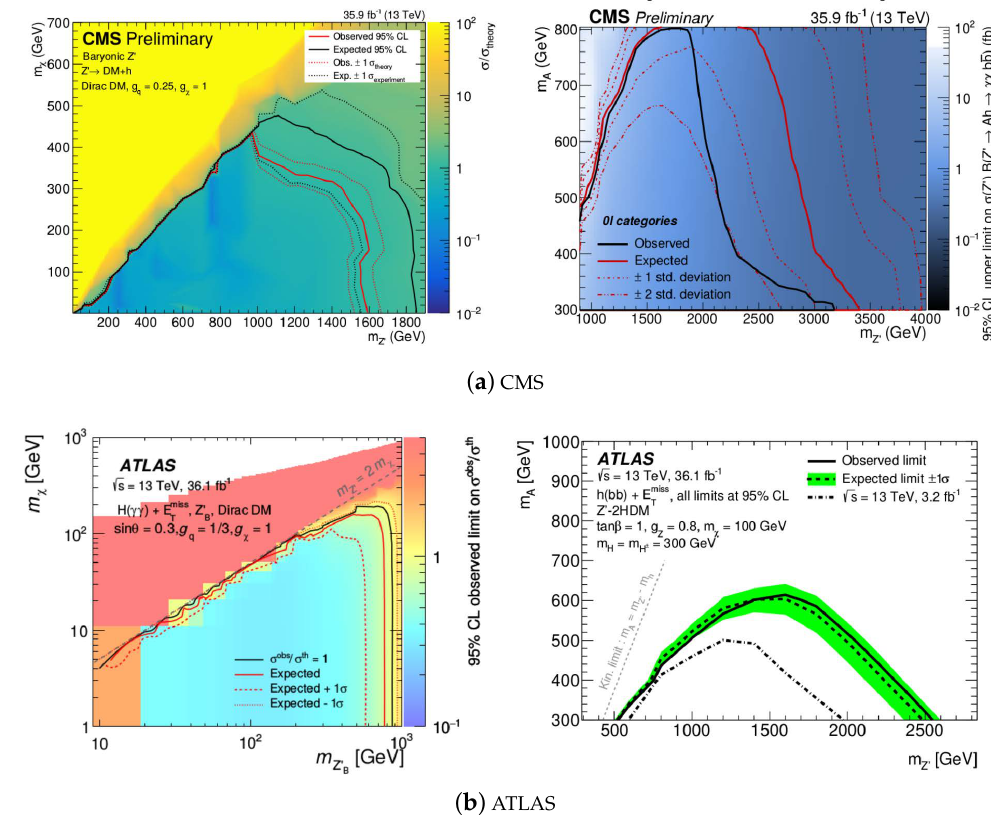
Figure 8. Main results for the mono-Higgs analyses in CMS [14,15] ( a ) and ATLAS [17,18] ( b ). On the left, the Z’-baryonic interpretation is shown, and on the right, the